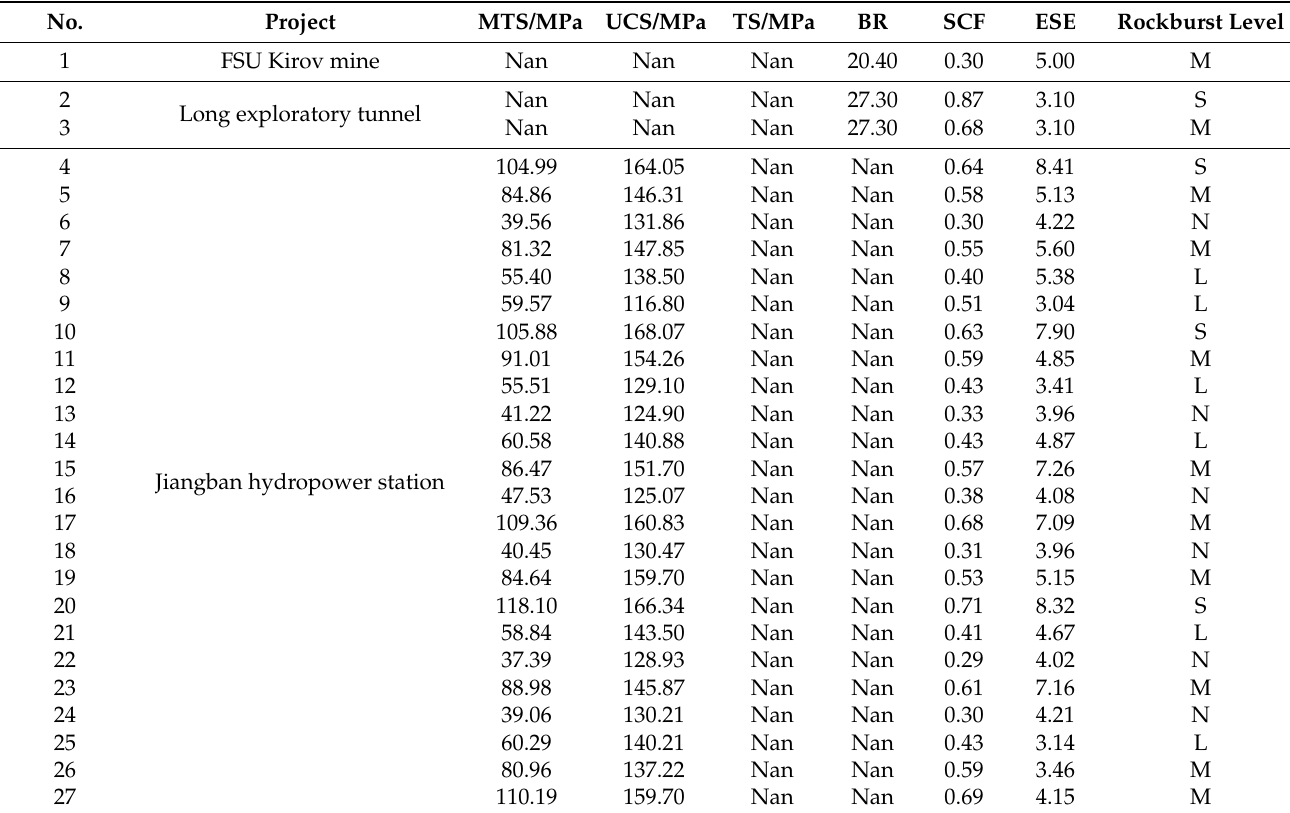
Table 2. The collected database with missing